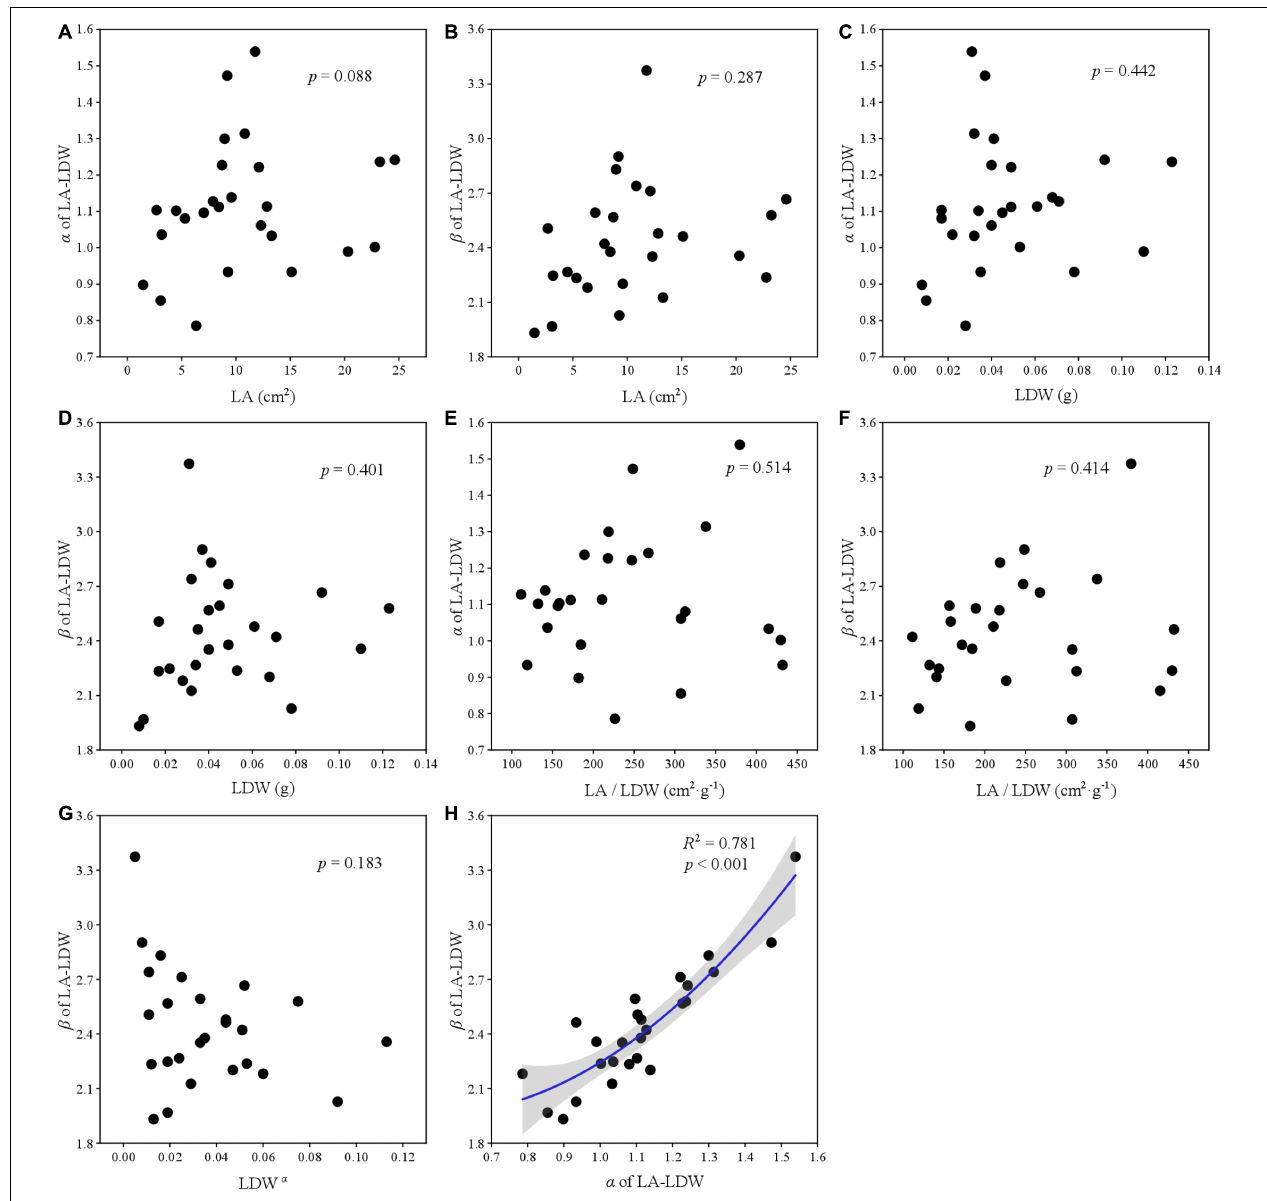
FIGURE 7 | The correlation relationship of parameters of LA and LDW. (A) The relationship between α and LA; (B) the relationship between β and LA; (C) the relationship between α and LDW; (D) the relationship between β and LDW; (E) the relationship between α and LA/LDW; (F) the relationship between β and LA/LDW; (G) , the relationship between β and LDW α ; and (H) the relationship between β and α .